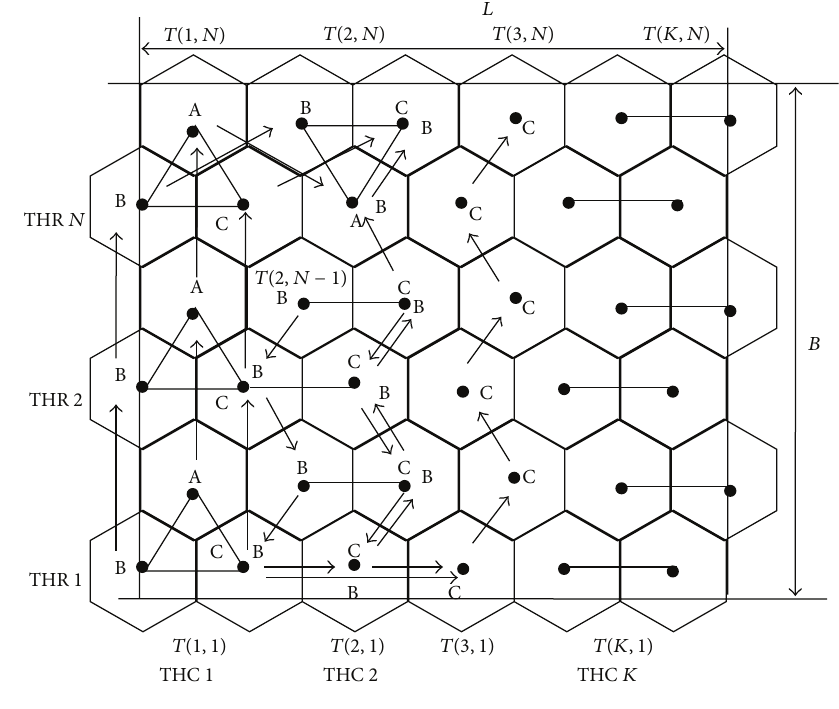
Figure 5: Line based MSNs traversal pattern.